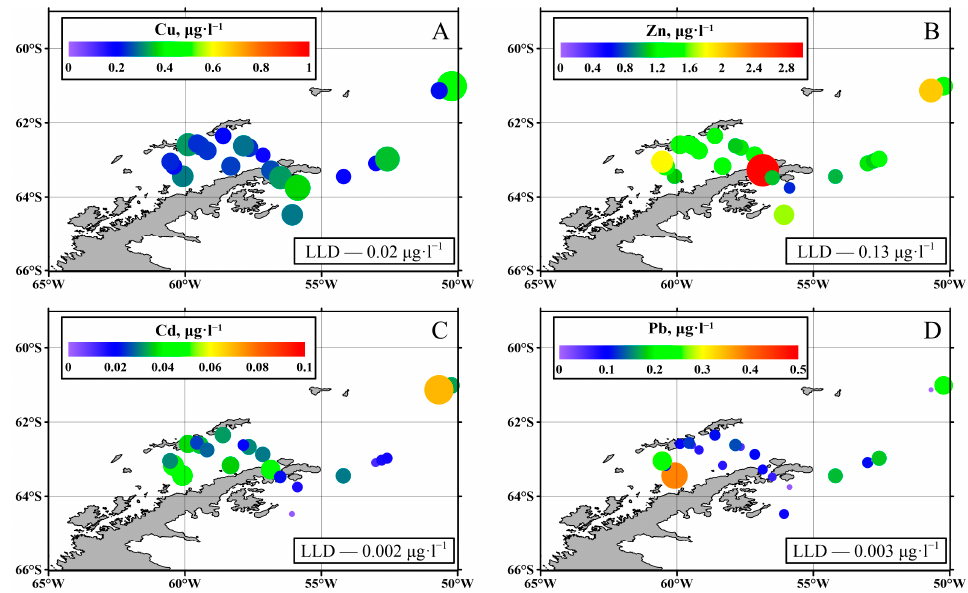
Figure 6. Concentrations of the main heavy metals (( A )—Cu; ( B )—Zn; ( C )—Cd; ( D )—Pb) in surface waters of the studied area of the Antarctic region.